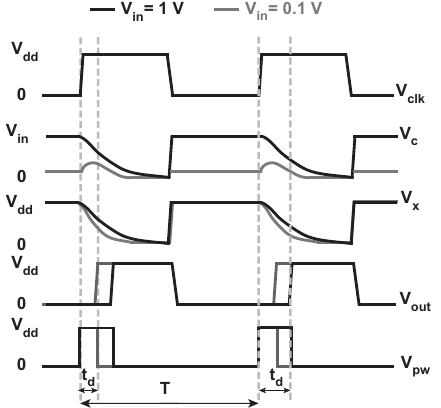
Figure 3. Input/output waveforms of VTC